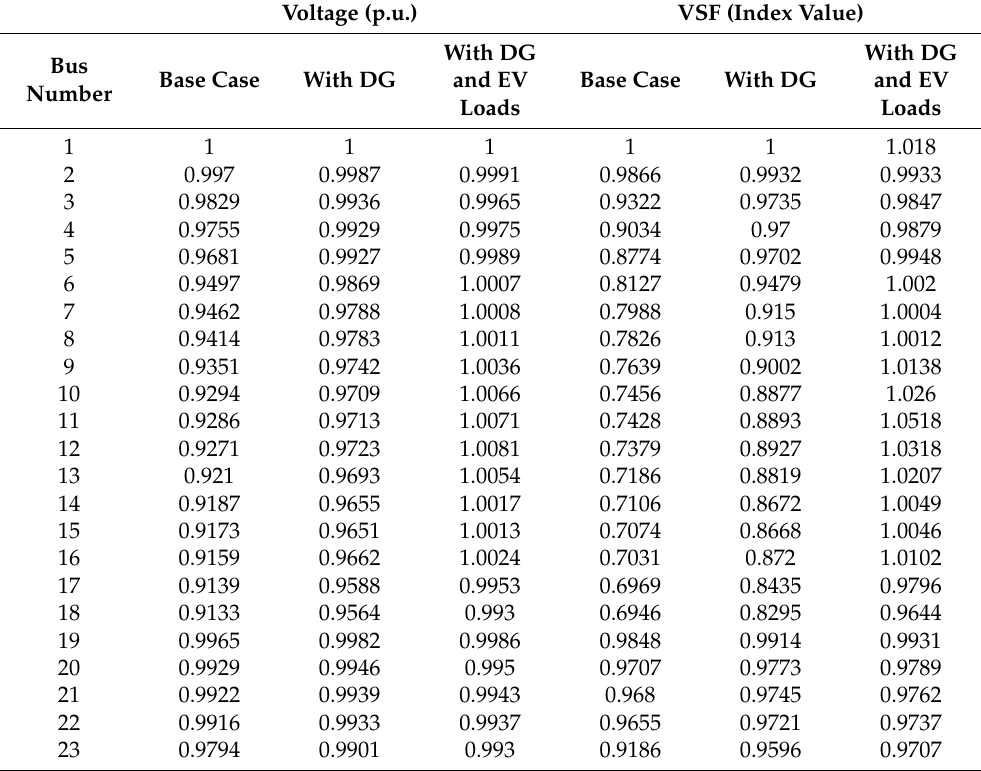
Table 1. Data estimated on IEEE-33 test buses with and without DGs and EV loads. Voltage (p.u.) VSF (Index